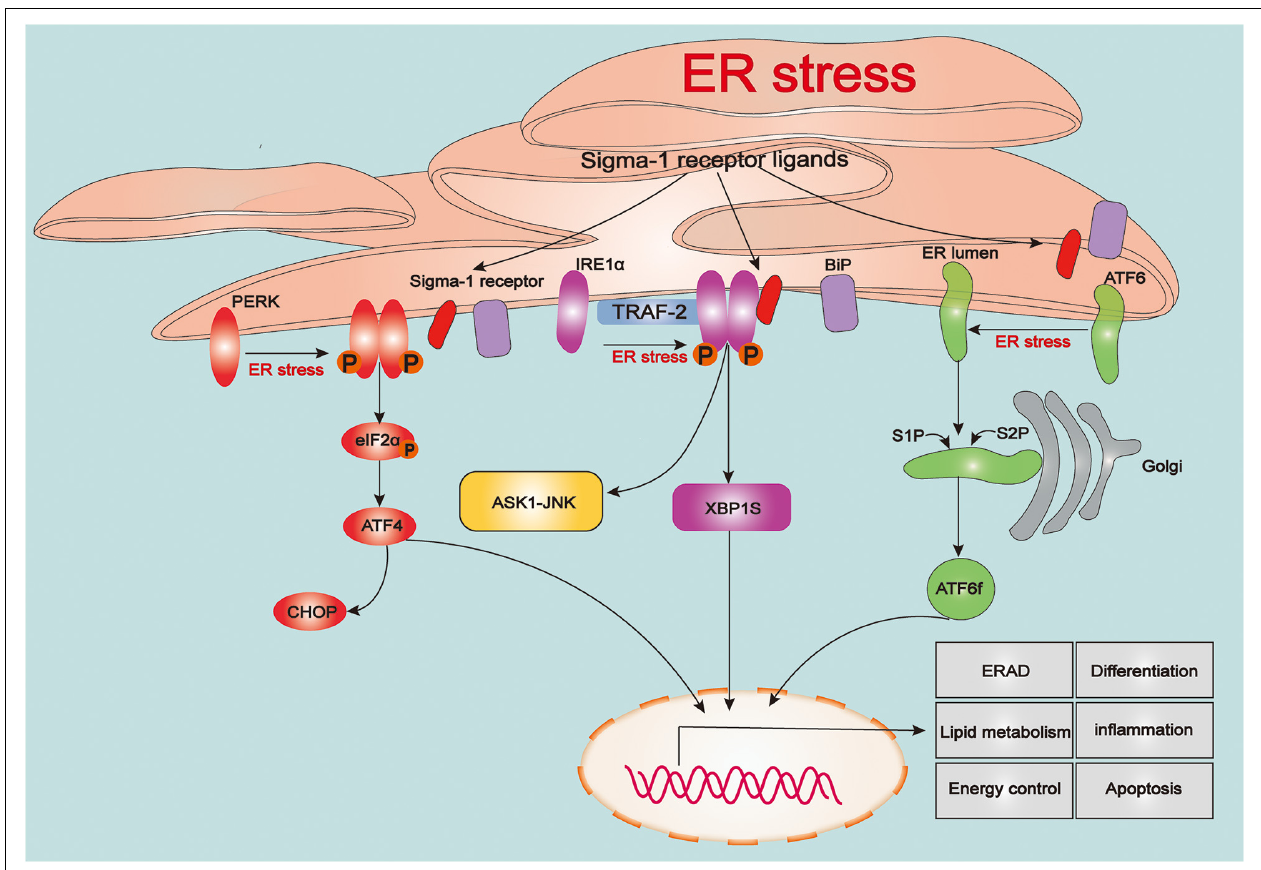
FIGURE 1 | The role of sigma-1 receptor in regulating the unfolded protein response signaling. Upon the endoplasmic reticulum (ER) stress, three types of sensors of ER stress: protein kinase RNA-like ER kinase (PERK), inositol-requiring enzyme 1 α (IRE1 α ) and activating transcription factor 6 (ATF6) are evoked and triggers a series of downstream signaling pathways that associated various pathophysiological processes including protein folding, lipid metabolism, energy control, differentiation, inflammation and apoptosis. Upon the ER stress or agonist stimulation, sigma-1 receptor (Sig-1R) dissociates from binding immunoglobulin protein (BiP) and immediately participates in regulating the unfolded protein response (UPR)-dependent signaling